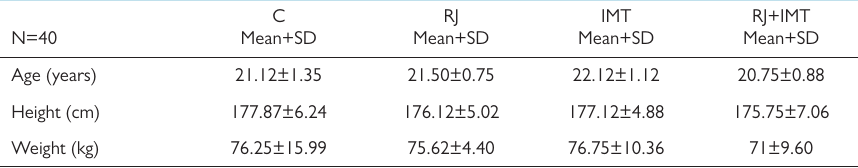
Table 1. Descriptiveinformation of the participants